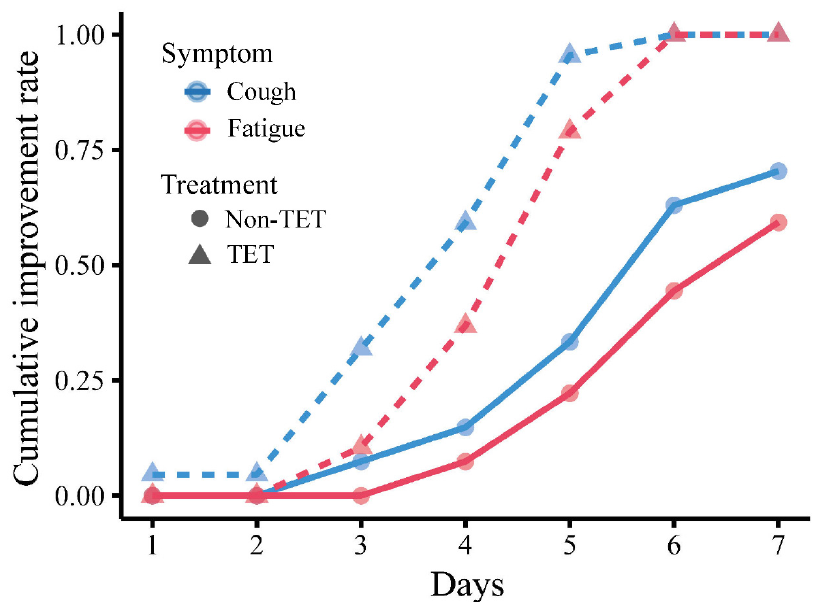
Figure 4. Cumulative day 7 improvement rate of cough and fatigue in moderate COVID-19 patients with and without tetrandrine treatment. The line for cough is red, and the line for fatigue is blue. TET, tetrandrine.